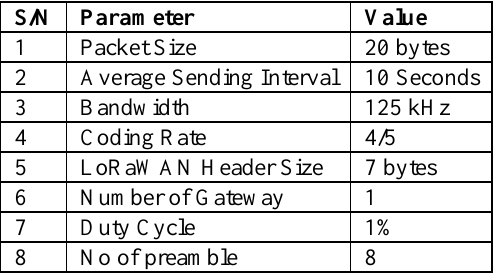
Table 2: Simulation